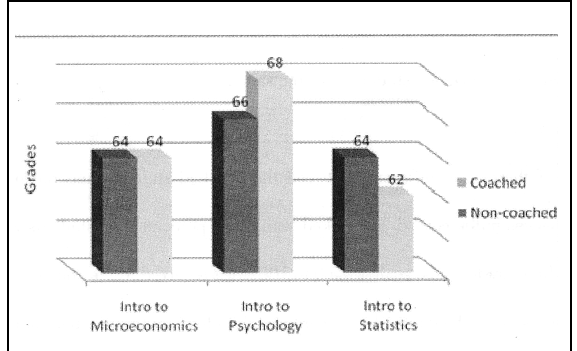
Figure 3. Percentage of students who took final